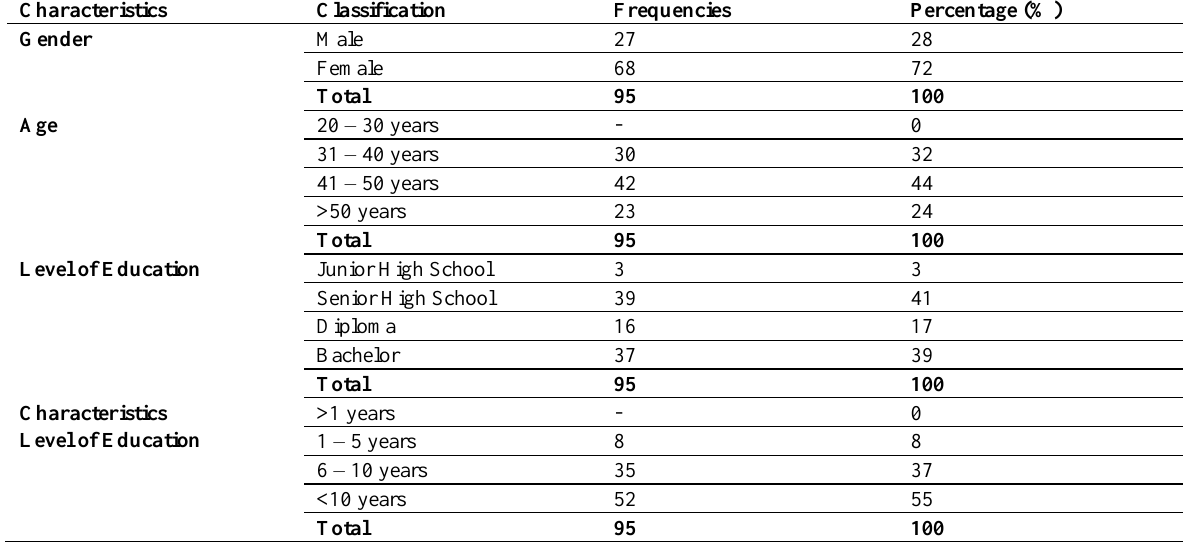
Table 1: Demographics of respondents